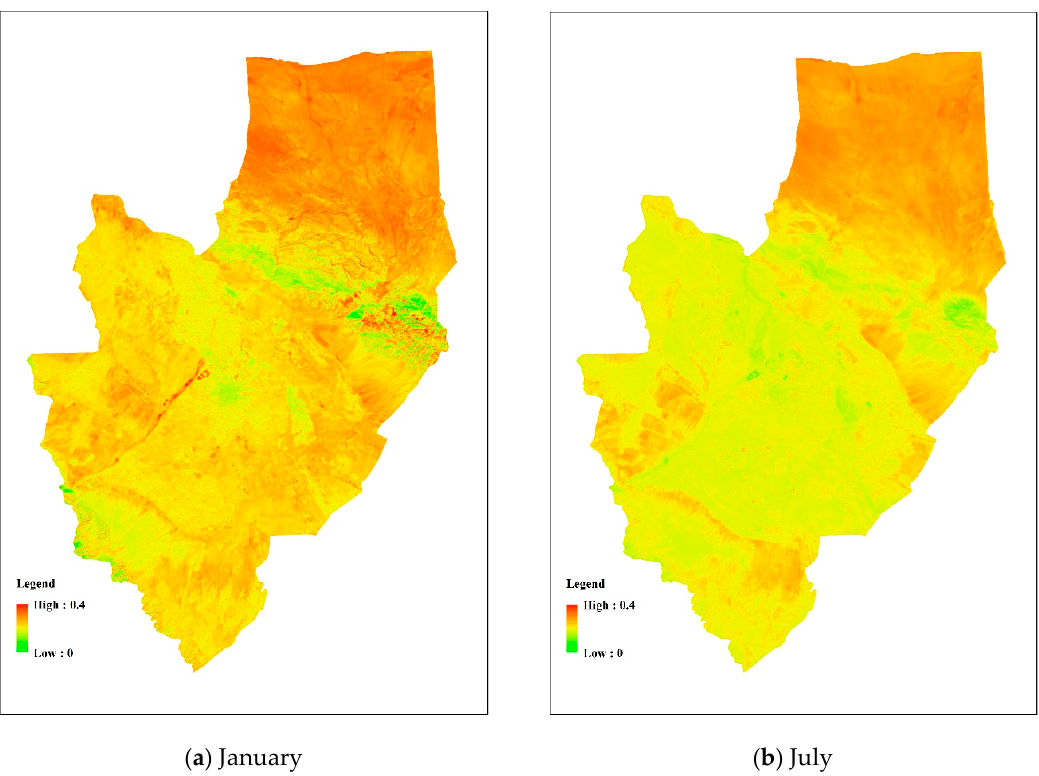
Figure 6. Spatial distribution of average surface albedo in ( a ) January and ( b ) July.